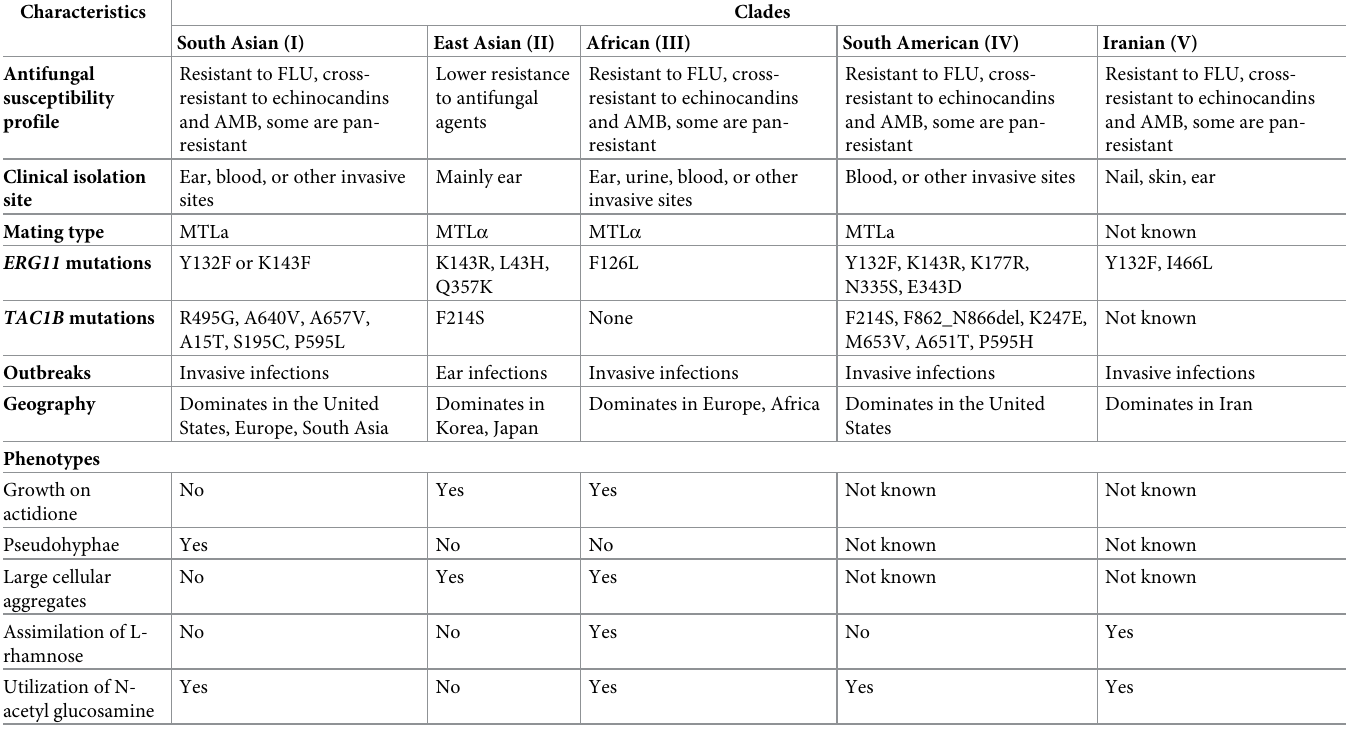
Table 1. Main characteristics of Candida auris